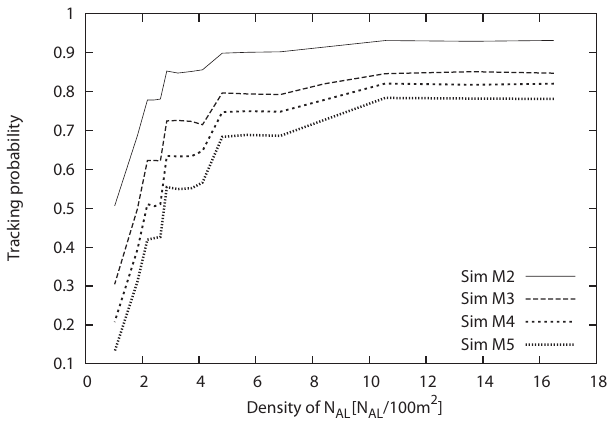
Figure 12. Effects of sensor density on tracking